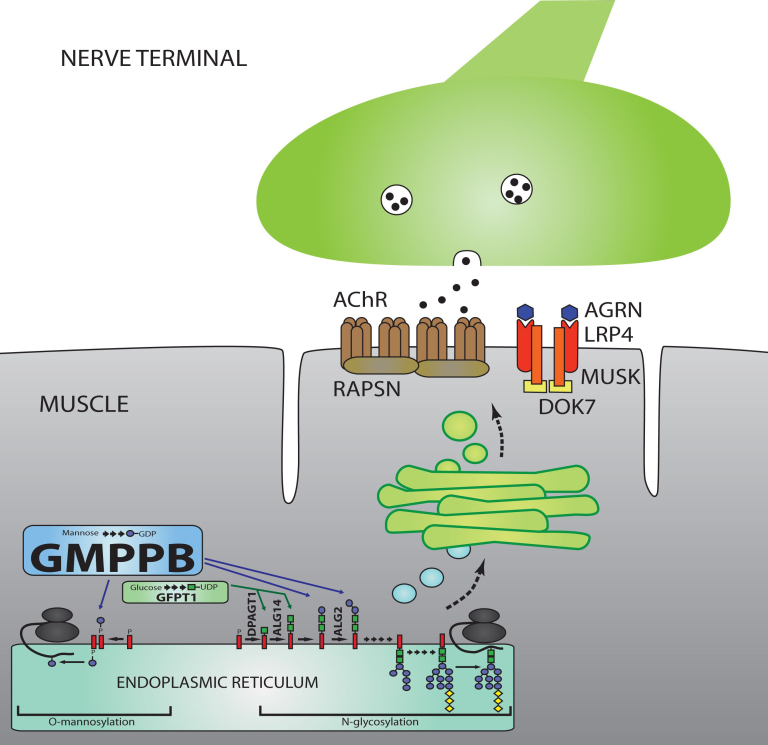
Congenital myasthenic syndromes are associated with impairments in neuromuscular transmission. Belaya et al. show that mutations of the glycosylation pathway enzyme GMPPB, which has previously been implicated in muscular dystrophy dystroglycanopathy, also cause a congenital myasthenic syndrome. This differential diagnosis is important to ensure that affected individuals receive appropriate medication.